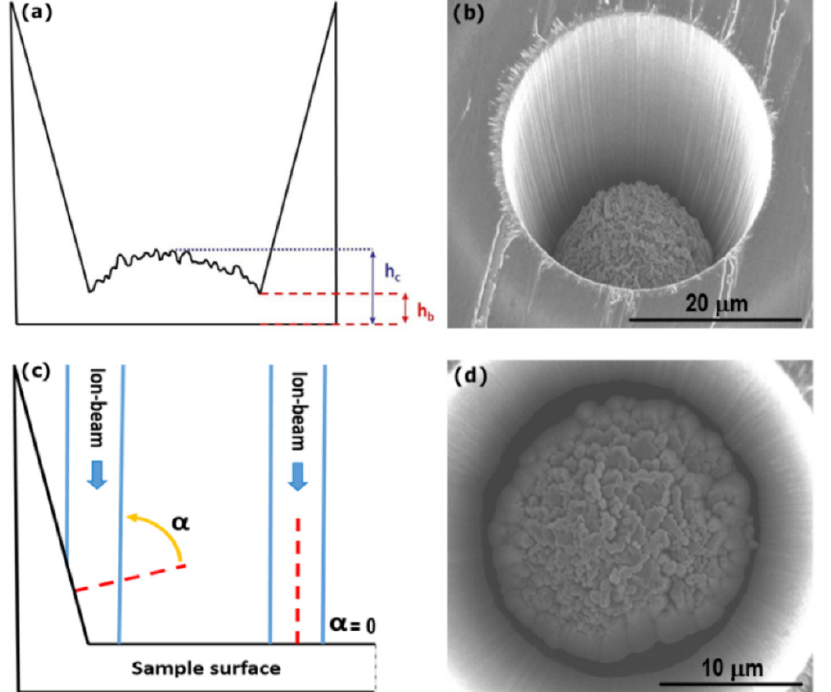
Figure 7. ( a ) Schematic cross-sectional view of a FIB-milled membrane showing re-deposition effects on tapered sidewalls and uneven bottom, characterized by a rough parabolic shape with minimum along the boundary (h b ) and maximum height (h c ) in the central region. ( b ) SEM image of a circular FIB-milled in which the bottom thickness unevenness is evident. ( c ) Schematic picture of an ion beam locally impinging on the sample with different incidence angles α , evaluated from the normal to the surface (red dashed lines). Close to the well sidewalls, part of the ion beam is hitting the surface at a large incidence angle, corresponding to a higher sputtering yield. ( d ) Top-view SEM image of a circular FIB-milled well showing the onset of a pass-through hole along the membrane boundaries where the effective sputtering rate is highest.